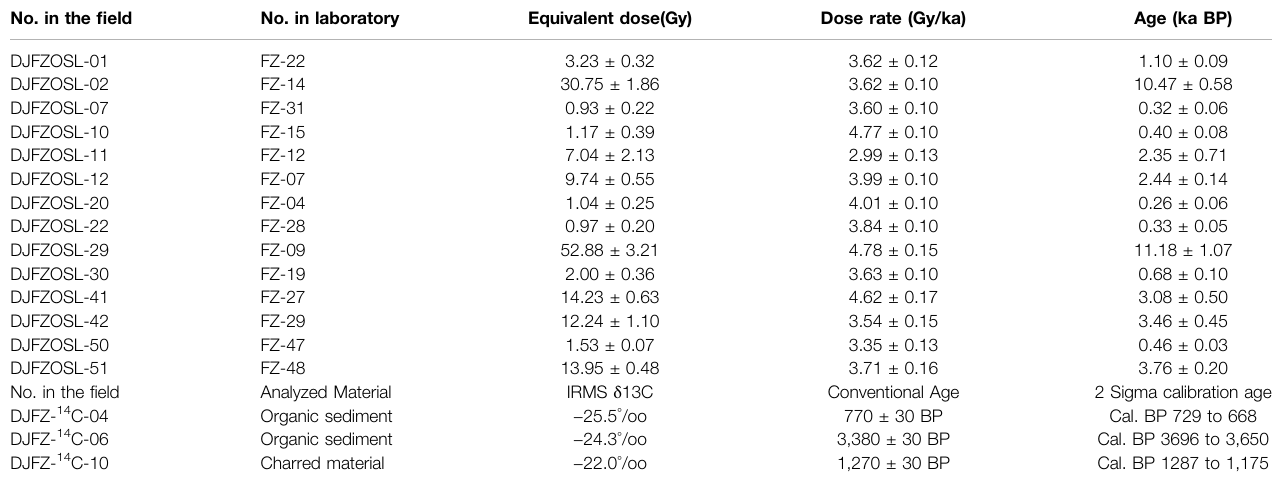
TABLE 1 | Measured ages of samples from trenches and outcrops along the DFZ. No. in the fi